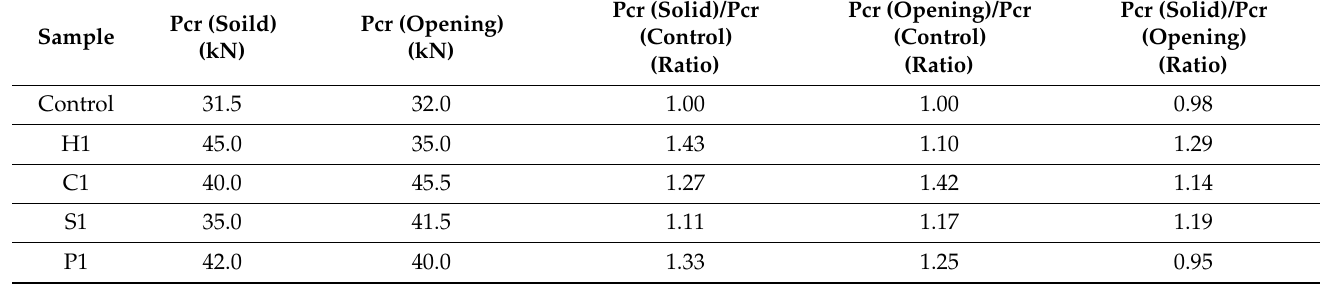
Figure 7. Cracks and failure pattern for solid slab with polyolefin. Table 7. Cracking and ultimate load of specimens for solid slab.